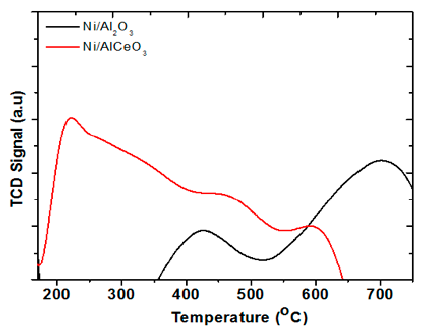
/ Al / AlCeO 2 O 3 and Ni 3